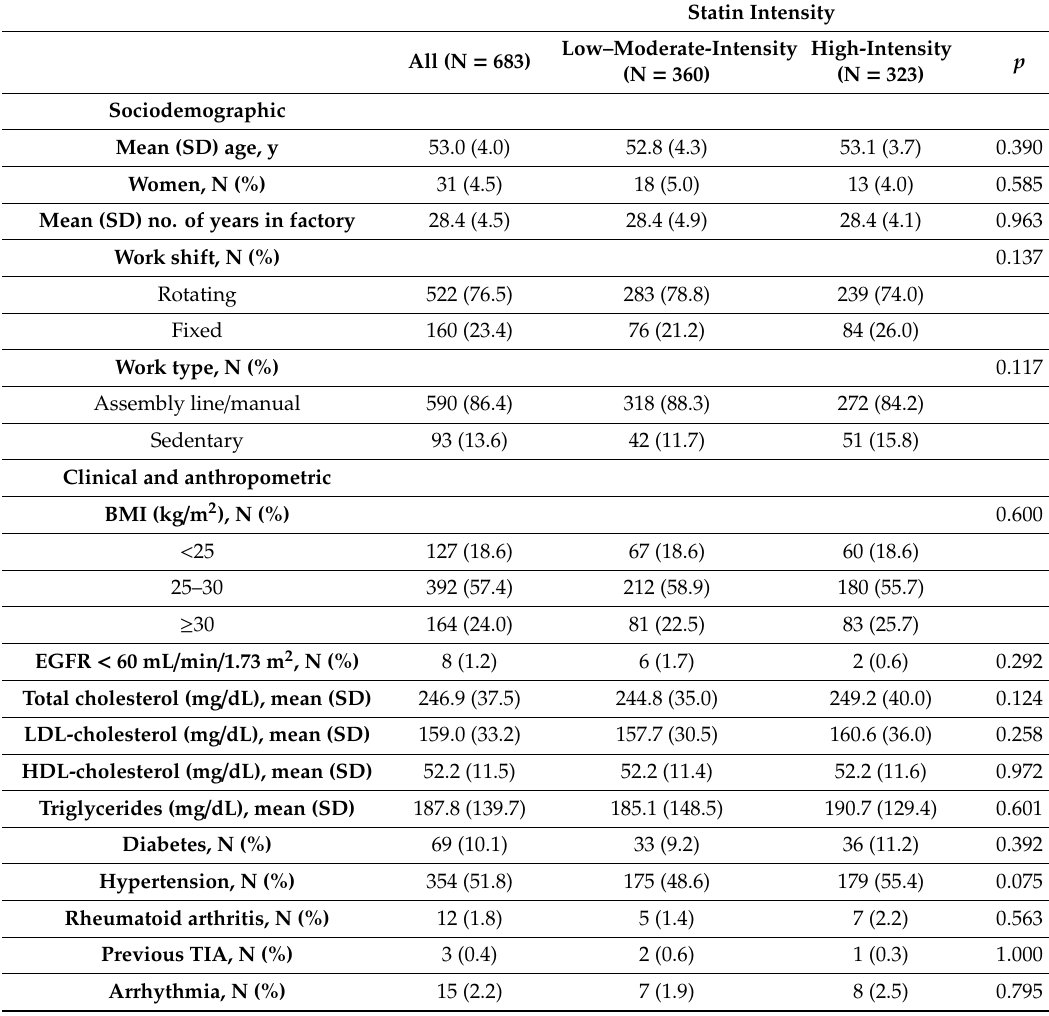
Table 1. Sociodemographic, clinical, and anthropometric characteristics of workers according to the intensity of statin prescribed.